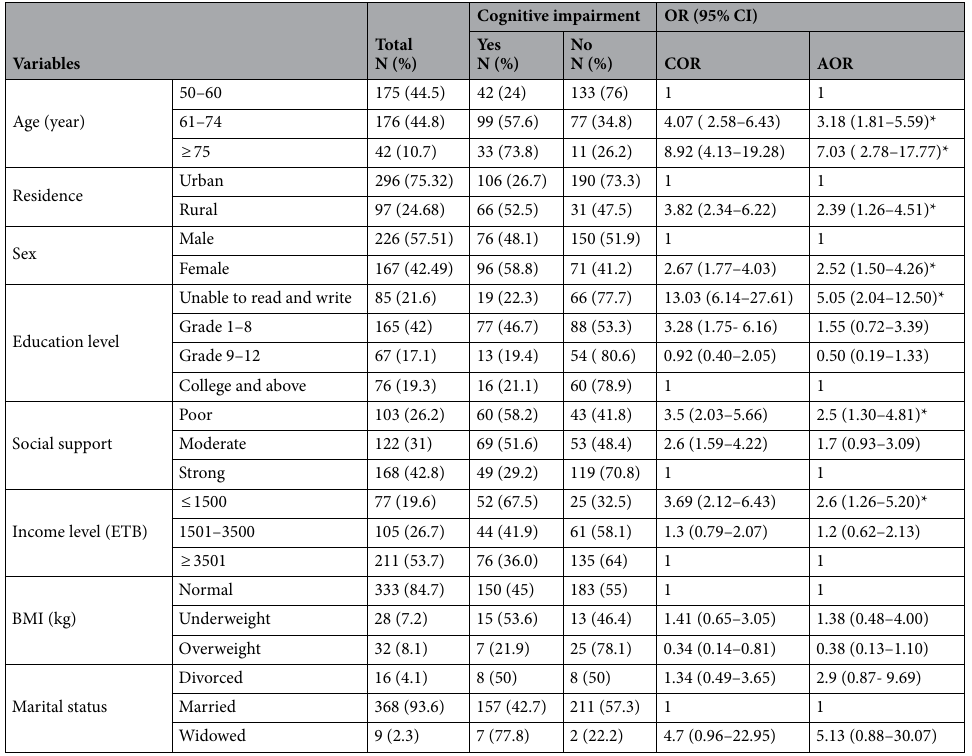
Table 2. Factors associated with cognitive impairment in binary and multiple logistic regression analyses among elderly community at Gondar town, 2020. *P-value ≤ 0.05, COR: crude odds ratio; AOR: adjusted odds ratio; CI: confidence interval; N: number; ETB: Ethiopian Birr, BMI: Body Mass